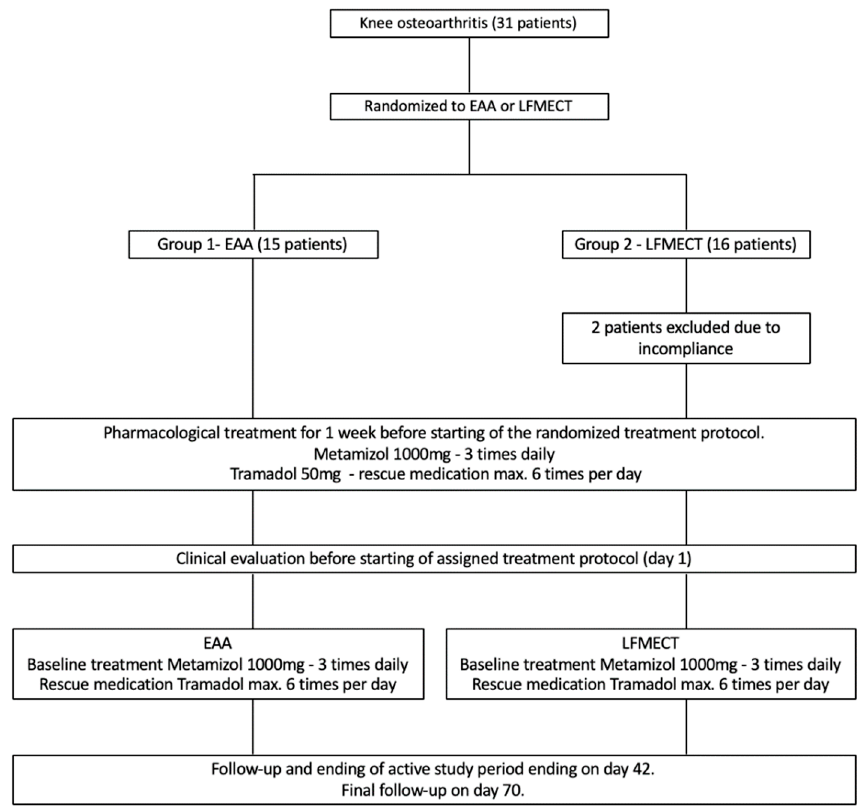
Figure 2. Flowchart showing the study protocol.